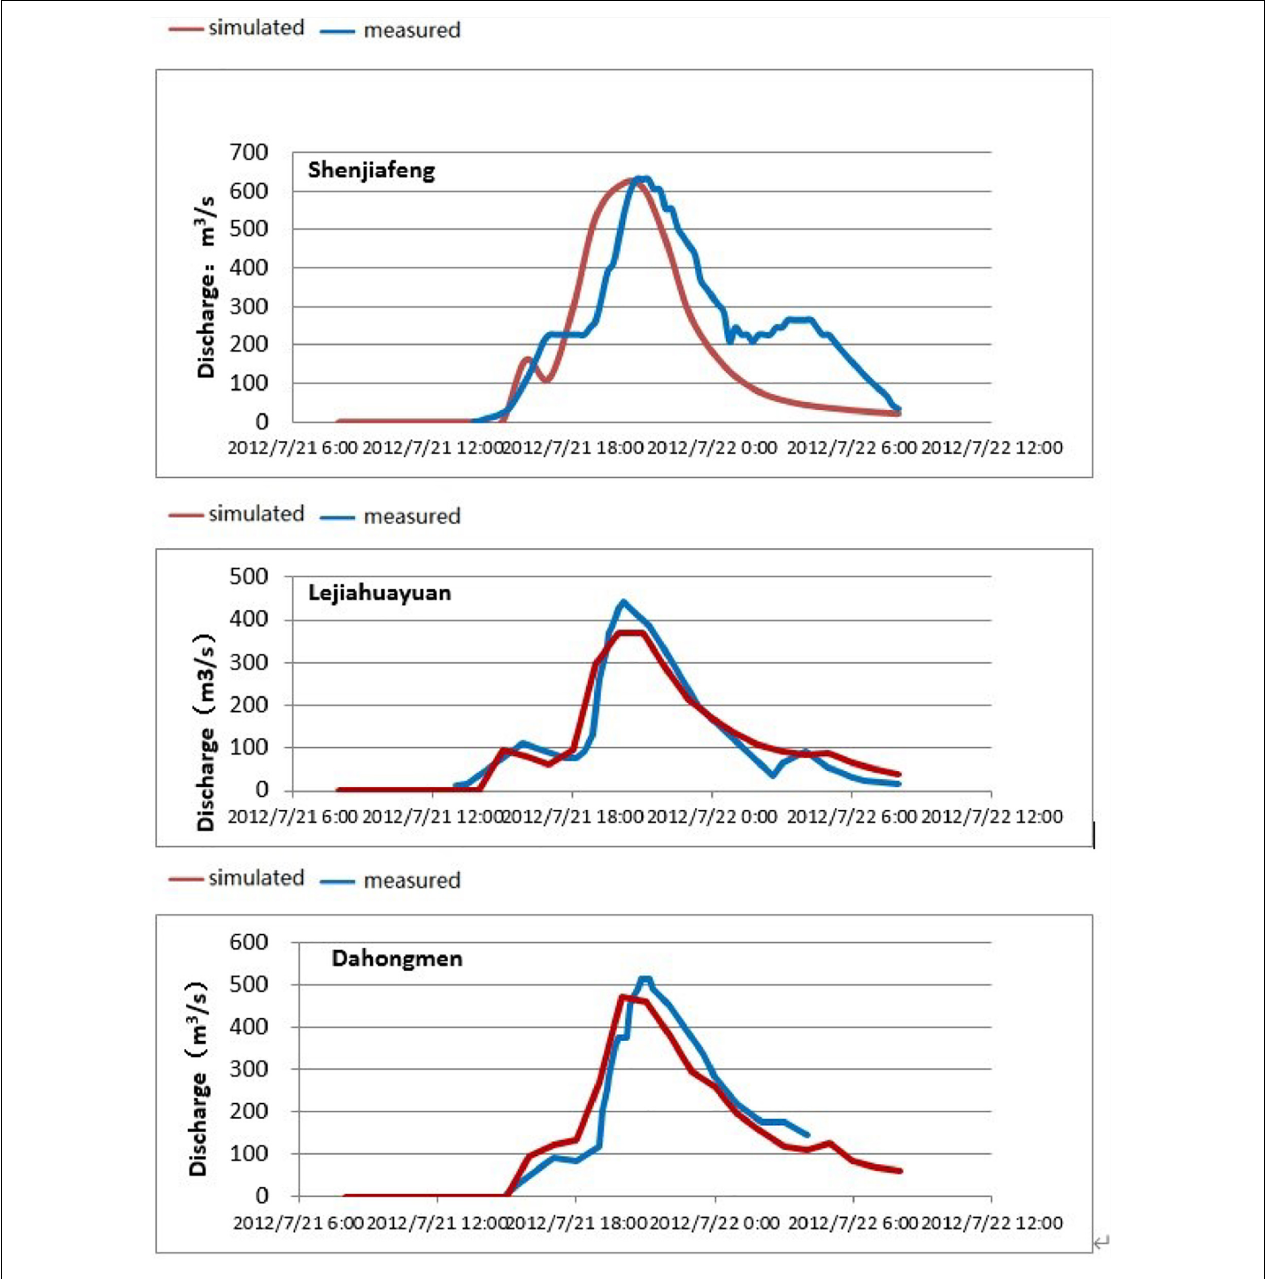
FIGURE 4 | The simulated and the measured river discharge of the 2012-07-21 rainstorm.